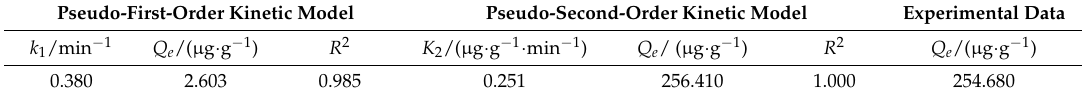
Table 2. The predicted parameters by pseudo-first-order and pseudo-second-order kinetic models and experimental data.